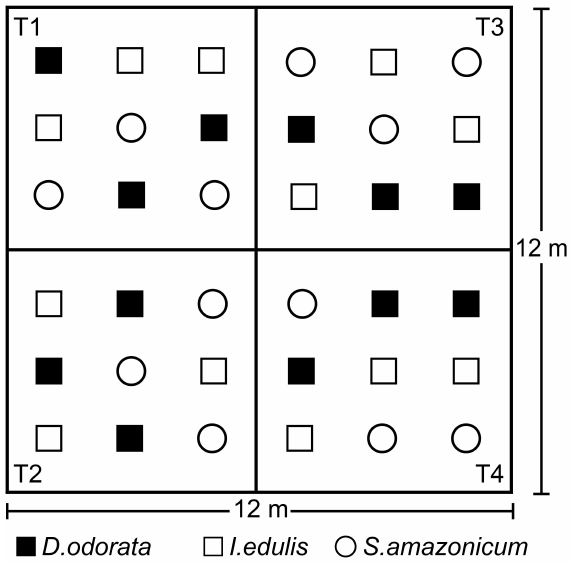
Figure 1. Design of each block (12 m ˆ 12 m) with four fertilization treatments. T1 = no fertilization, T2 = post-planting chemical fertilization, T3 = post-planting organic fertilization and T4 = combined chemical and organic post-planting fertilization. The three species include the following: (cid:4) , D. odorata